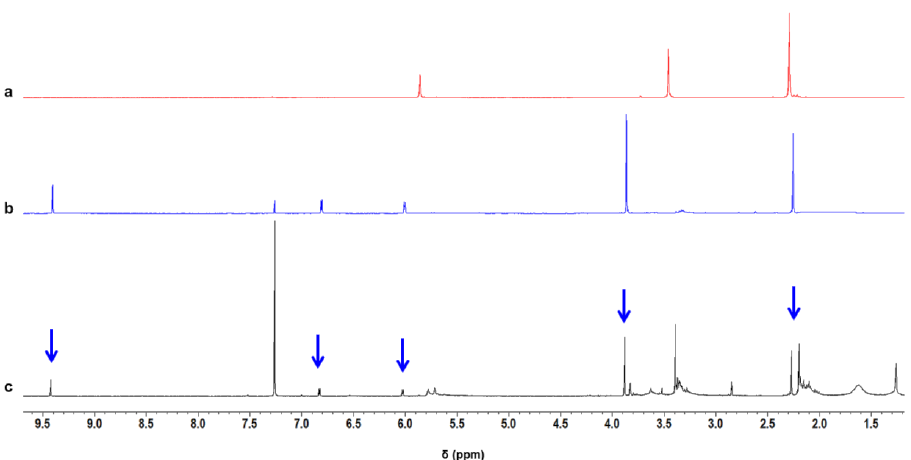
Figure 5. 1 H NMR spectra (400 MHz, CDCl 3 ) of pristine TMP ( a ), DMP-CHO (see Table 2) ( b ), liquid product obtained by heating TMP in the presence of catalytic amount of HSAG at 150 °C ( c ). The arrows indicate the peaks assigned to DMP-CHO.